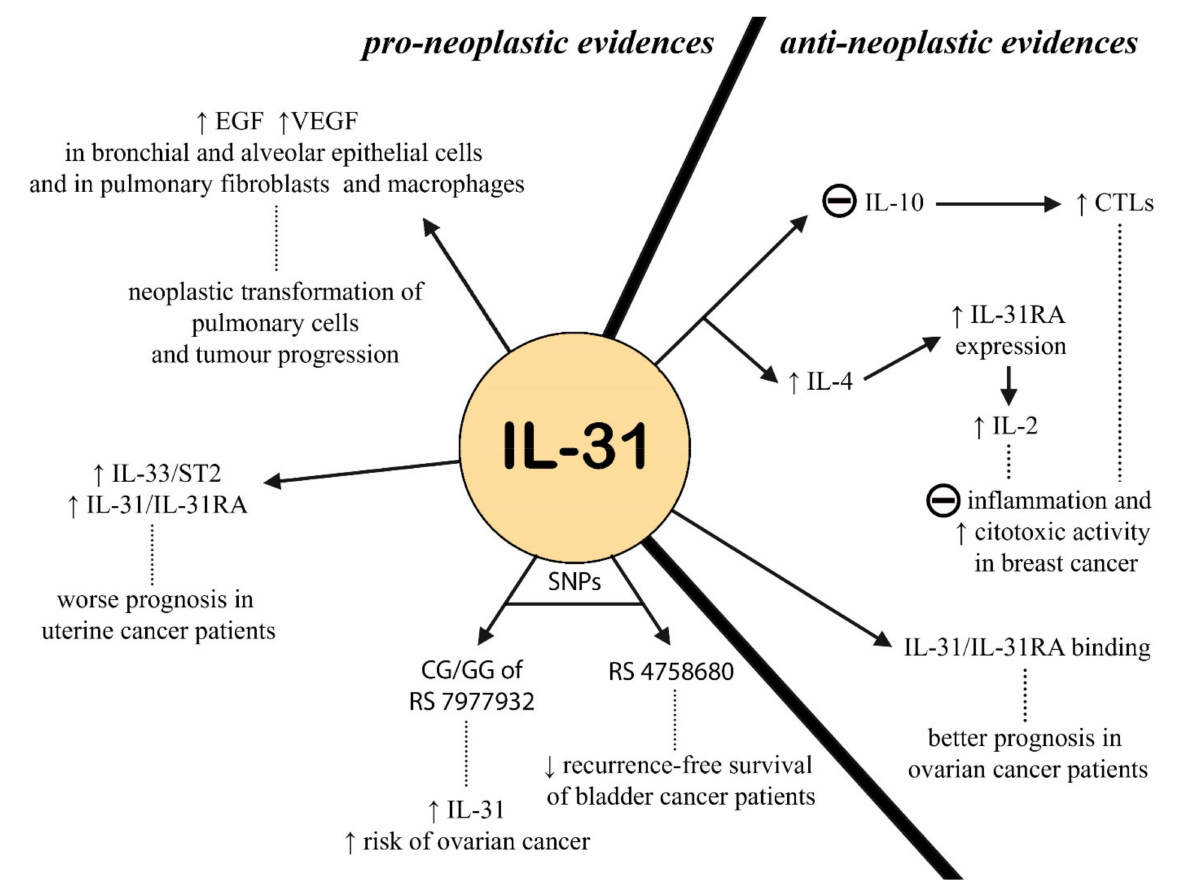
Figure 4. Role of IL-31 in oncological diseases: on one side is the mechanisms that could explain a pro- neoplastic action, on the other is the evidence that suggests an anti-neoplastic role (EGF = epithelial growth factor; VEGF = vascular endothelial growth factor; SNPs = single nucleotide polymorphisms; CTLs = cytotoxic T